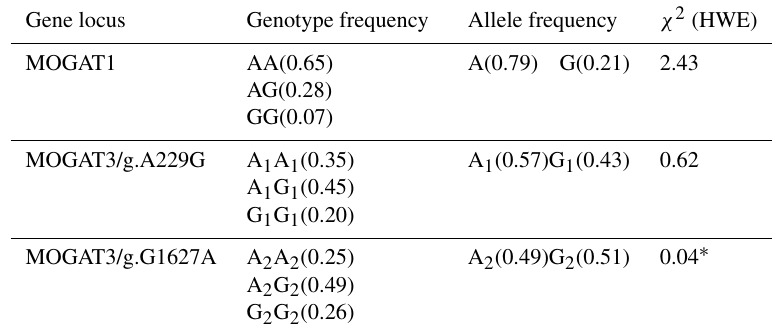
Table 2. Genotype and allele frequencies of the MOGAT1, MOGAT3/g.A229G, and MOGAT3/g.G1627A.